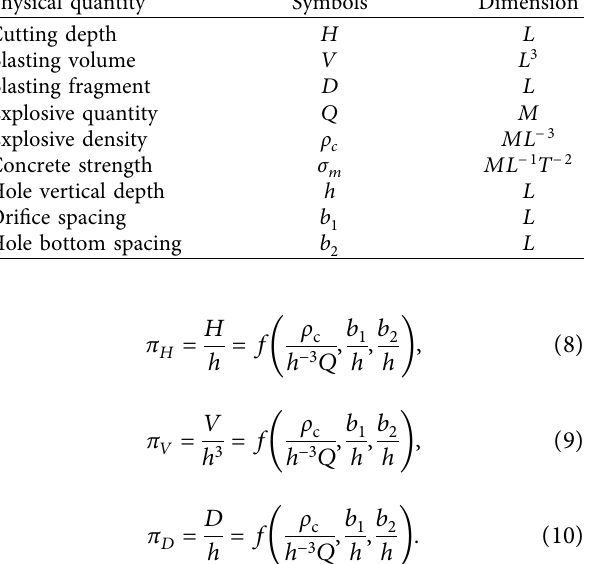
Table 1: Blasting physical dimension. Physical